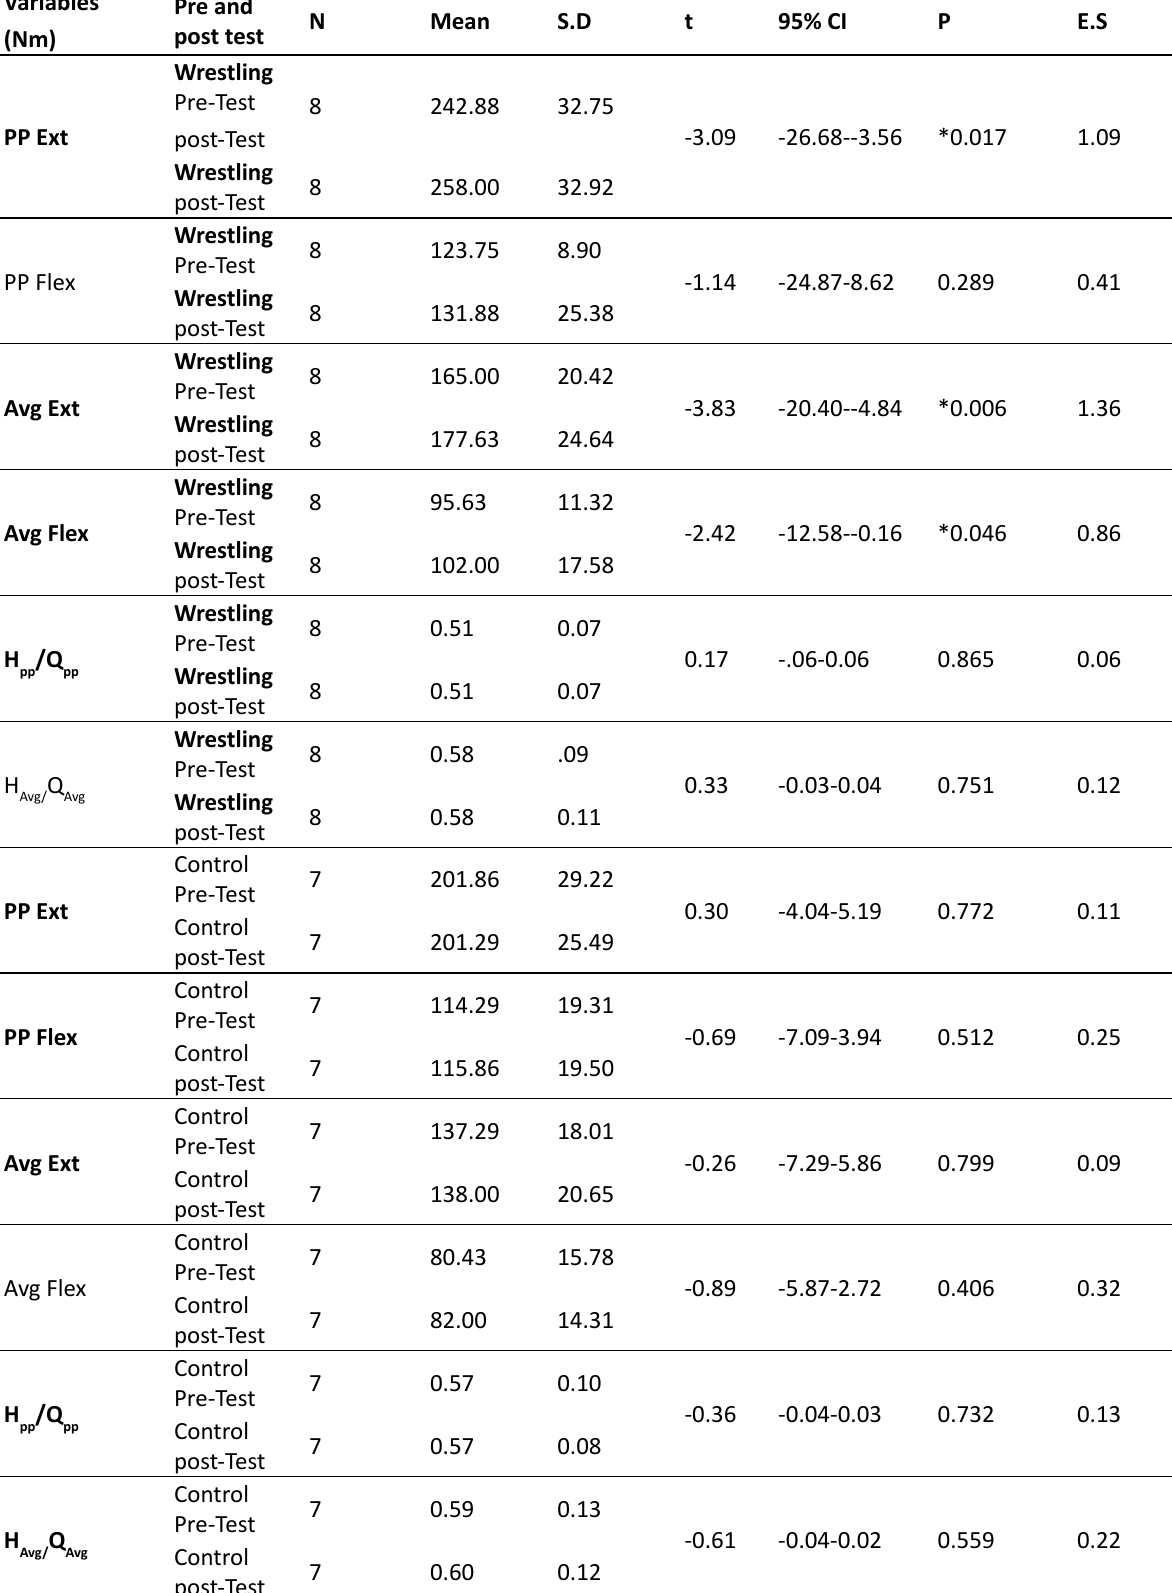
Table 2. Left leg pre and post-test isokinetic torque outputs of wrestling and control groups